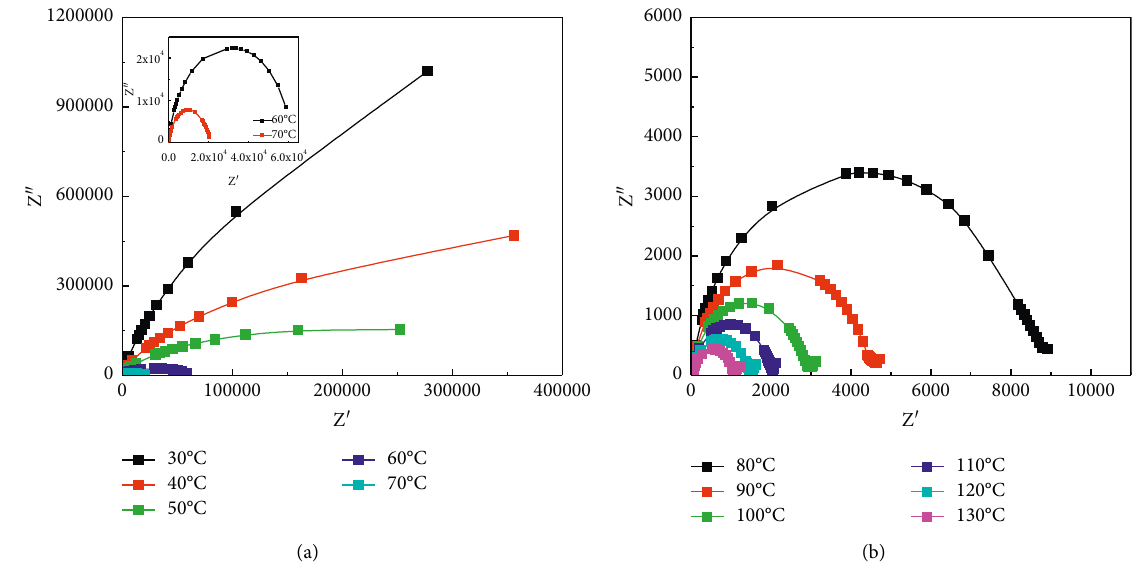
Figure 7: Complex plane plots (Z ′ -Z ″ ) for 0.5wt.% FeCl from 80 to 130 °